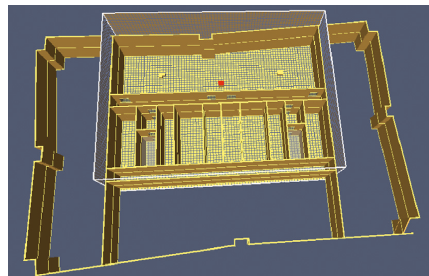
Figure 13: Structure of fire scenario E.